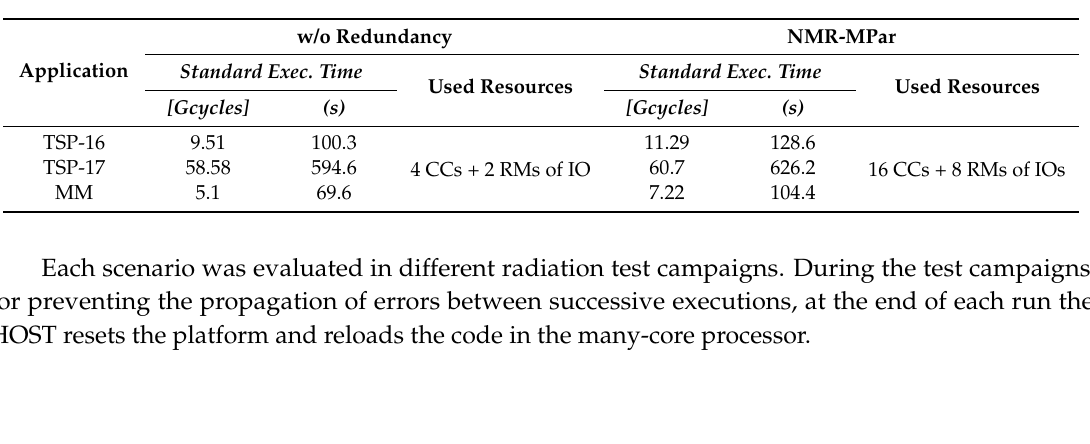
Table 3. Benchmark characteristics for each scenario.